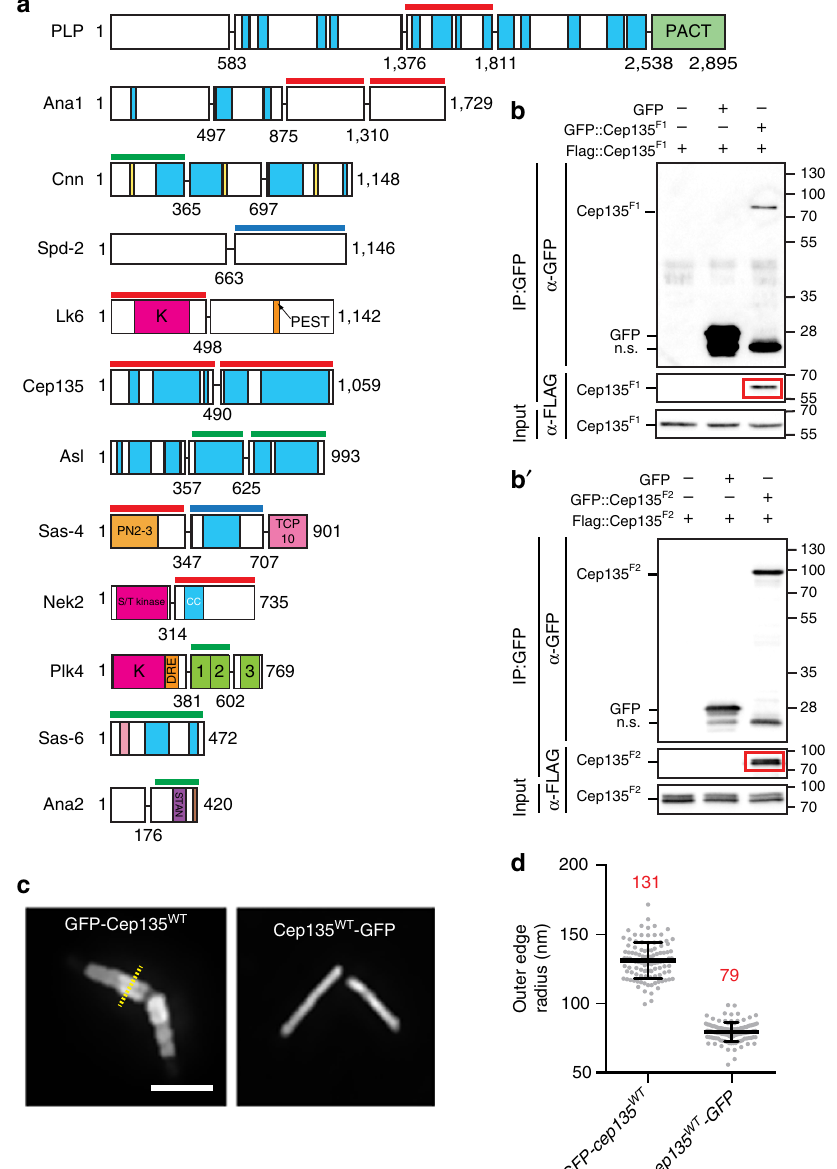
Figure 3 | Multimerization is a common feature of centrosome proteins. ( a ) Schematics (as in Fig. 2a) of all of the proteins in the screen that contained a region able to self-associate. Red lines indicate fragments with novel interactions. Blue lines indicate fragments where the interaction is known in a different experimental system or where the region of interaction in Drosophila has been refined by our screen. Green lines indicate previously described interactions. Numbers are amino acids. Corresponding Y2H data are in Supplementary Fig. 4. ( b , b 0 ) Co-IPs showing the Cep135 N-term and Cep135 C-term self-associations. Red box highlights protein in the IP. Sizes are in kD. ( c ) Cep135 adopts an extended conformation in centrioles. Sagittal views of centrioles from spermatocytes in transgenic flies expressing Cep135 tagged with GFP at the N- and C-termini. All measurements of spermatocyte centrioles were taken with a line scan perpendicular to the long axis of centrioles (representative linescan, yellow). ( d ) Outer edge measurements of centrioles from spermatocytes in transgenic animal testes. Mean (red number) ± s.d. Ns are centrioles—GFP::Cep135 ¼ 109, Cep135::GFP ¼ 117, pooled from three experiments. Scale bar, 1 m